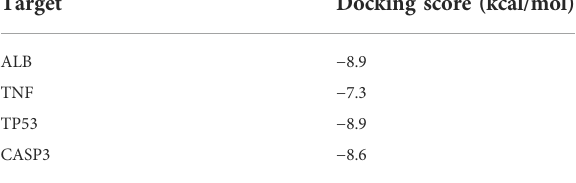
TABLE 3 The top four molecular docking with high binding